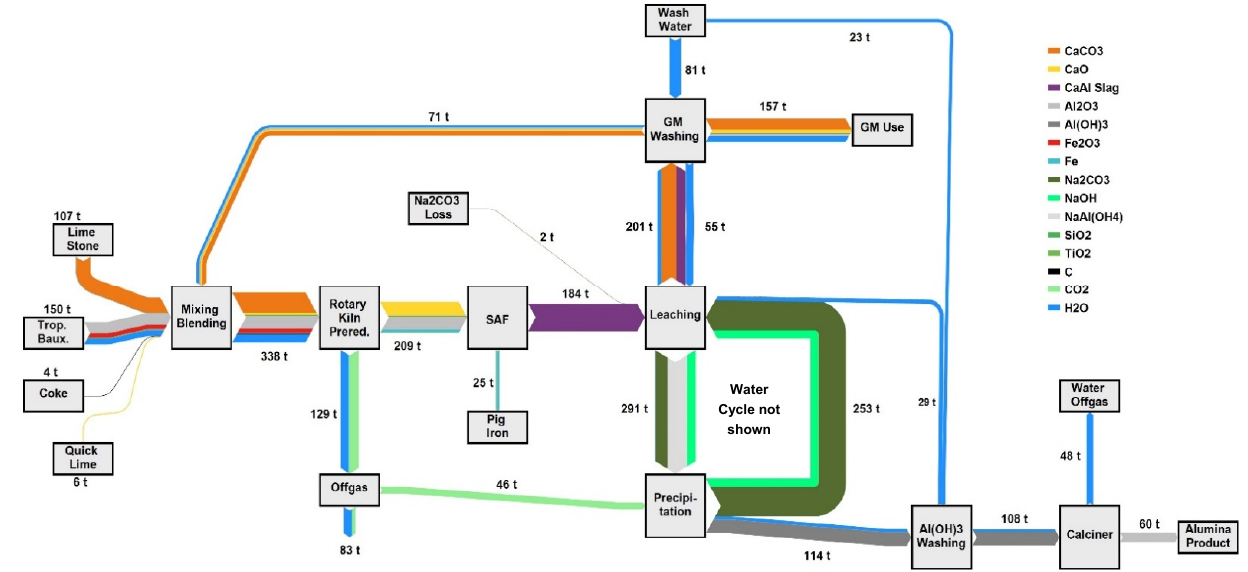
Figure 2. Sankey diagram of the reengineered Pedersen Process.